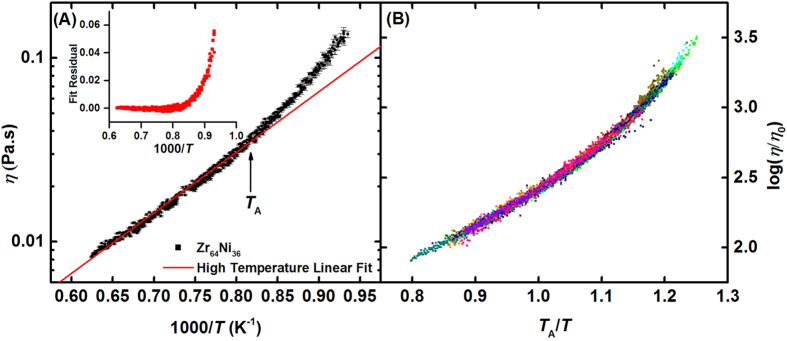
(A) Typical example of the behavior of log(η) at high temperature, showing a departure from Arrhenius behavior on cooling below TA. Error bars are one s.d. (B) Scaled universal curve for all measured viscosity data.